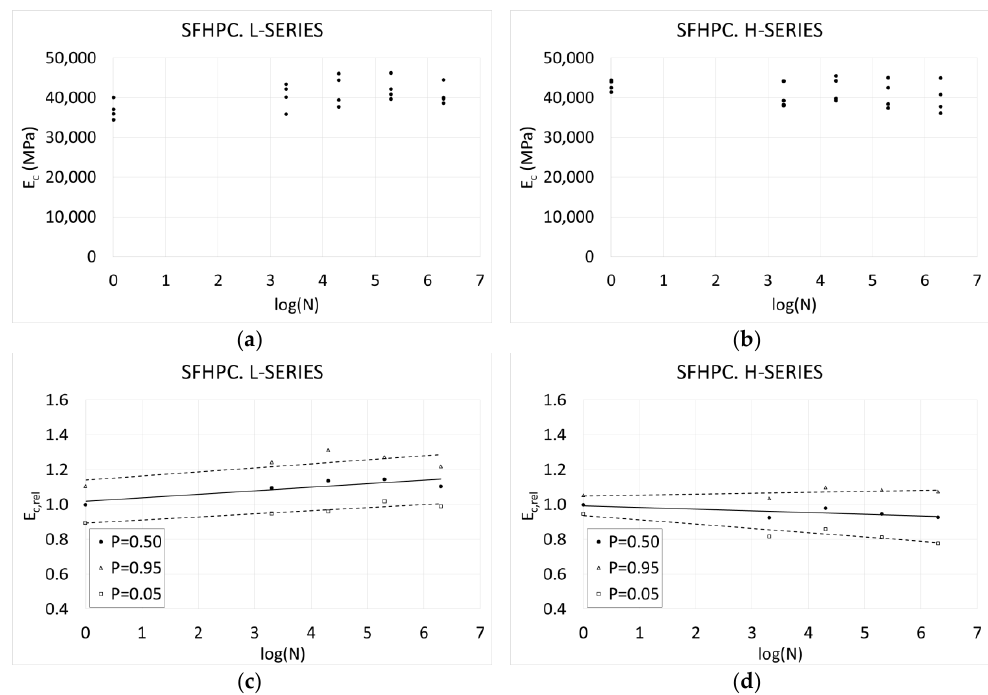
Figure 8. Variation of the compressive modulus of elasticity with the number of cycles. SFHPC ( a ) L-Series. Raw values. ( b ) H-Series. Raw values. ( c ) L-Series. Maximum, minimum, and average relative values, and tendency lines. ( d ) H-Series. Maximum, minimum, and average relative values, and tendency lines.